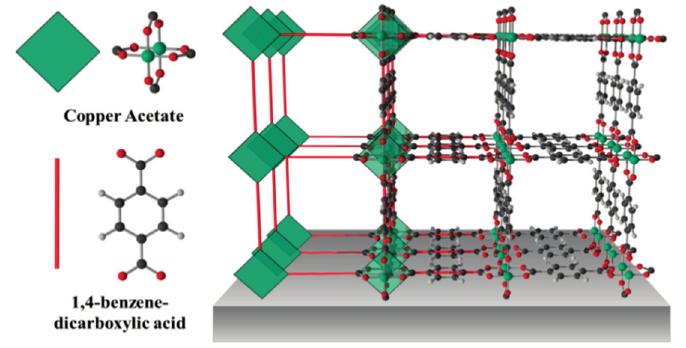
Figure 3. Schematic representation of the 2D Cu(bdc)·xH 2 O MOF thin film structure on a sensor chip.